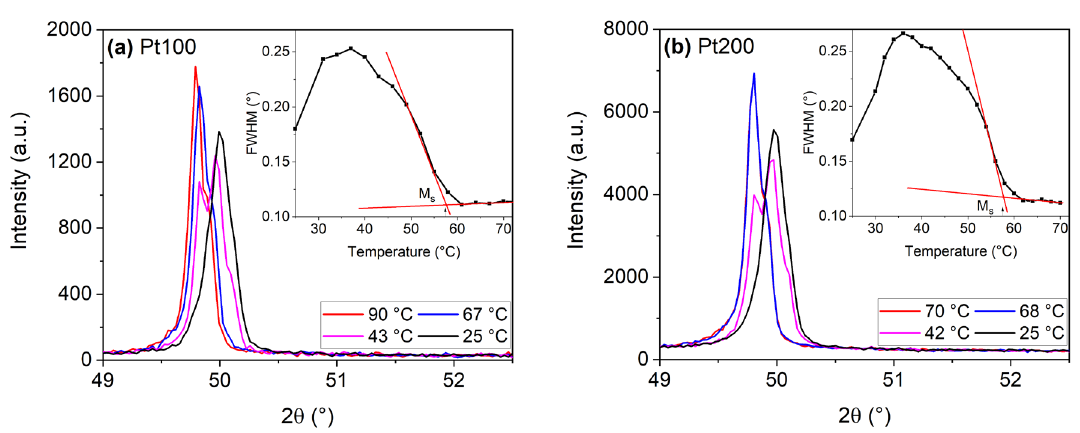
Figure 9. The diffractograms for samples Pt100 ( a ) and Pt200 ( b ) measured in the (110) B2 Figure 9. The di ff ractograms for samples Pt100 ( a ) and Pt200 ( b ) measured in the (110) B2 neighborhood neighborhood at various temperatures between 25 and 90 °C. The insets show the corresponding at various temperatures between 25 and 90 ◦ C. The insets show the corresponding FWHM (full width at half maximum) of the (110) B2 peaks in dependence on FWHM (full width at half maximum) of the (110) B2 peaks in dependence on temperature.